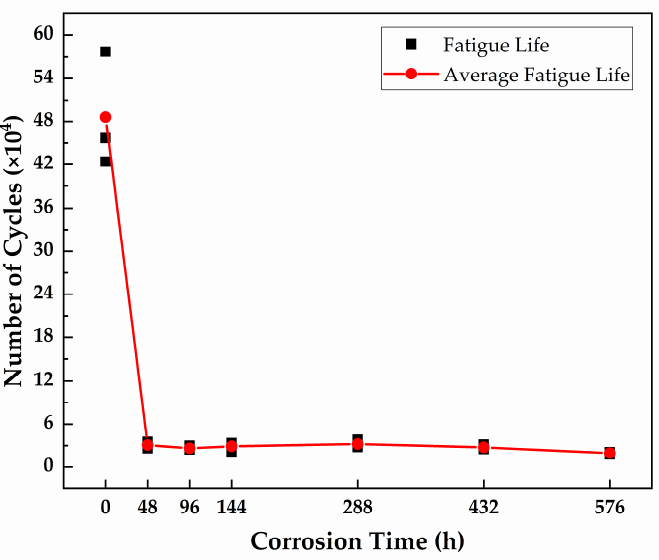
Figure 6. Fatigue life of the 7B04-T74 aluminum alloy after 576 h alternate immersion test.